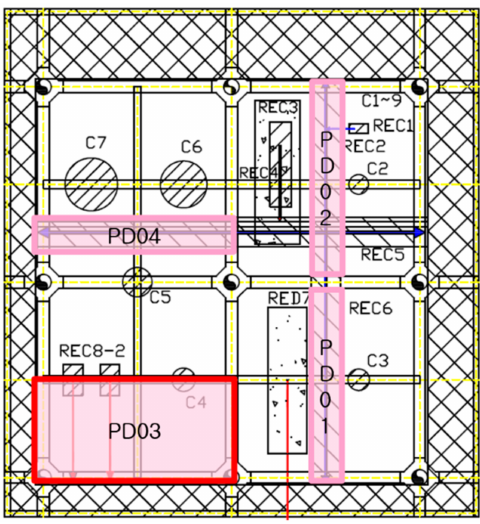
Figure 7. Drop zone and drop point